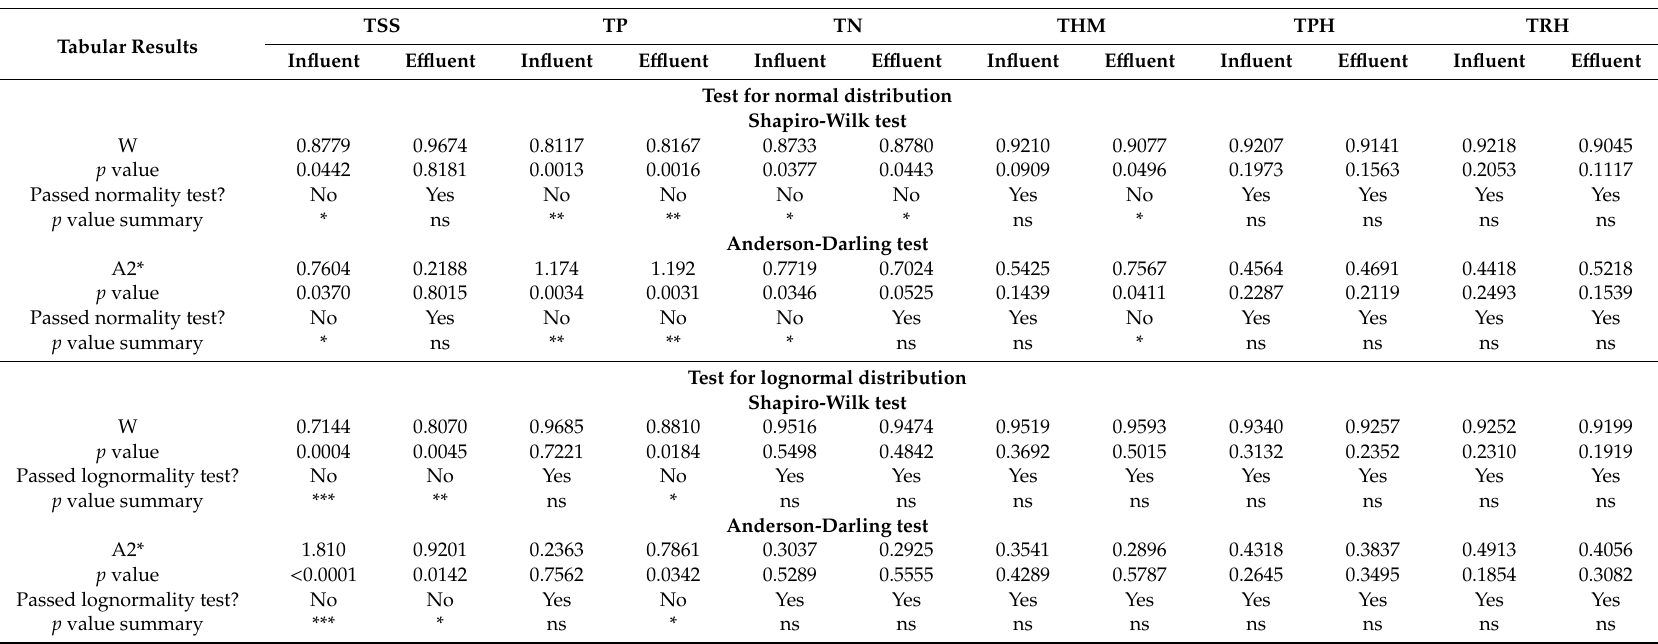
Table A8. Normal and Lognormal distribution test for EMC influent and e ffl